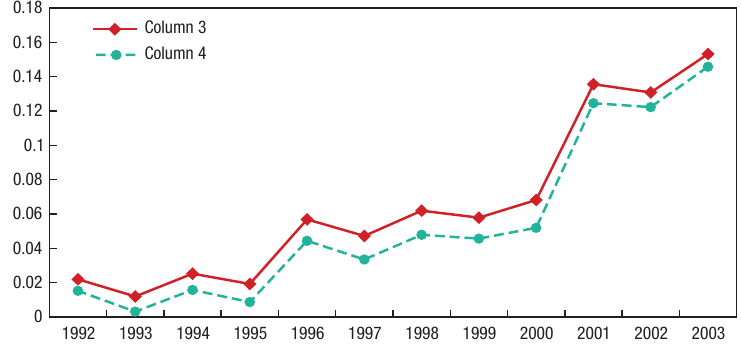
Fig. 2. Trend of firms’ R&D productivity in Taiwan,